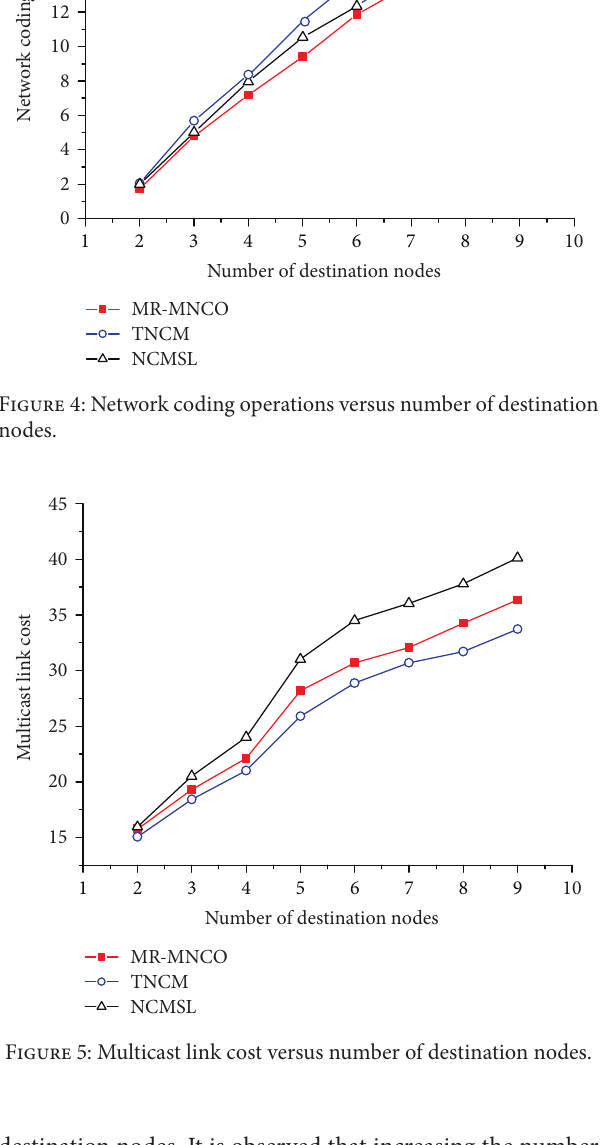
destination nodes. It is observed that increasing the number of destination nodes can lead to a significant reduction in the deterioration of the number of network coding operations.